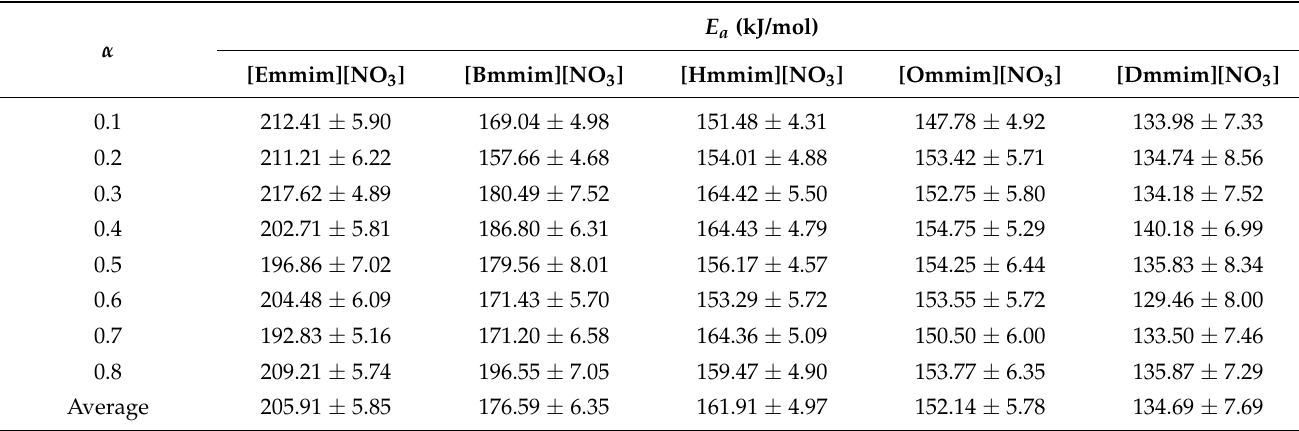
Table 4. The activation energy obtained by the Friedman method for thermal decomposition of the 1-alkyl-2,3- dimethylimidazole nitrate ionic liquids.